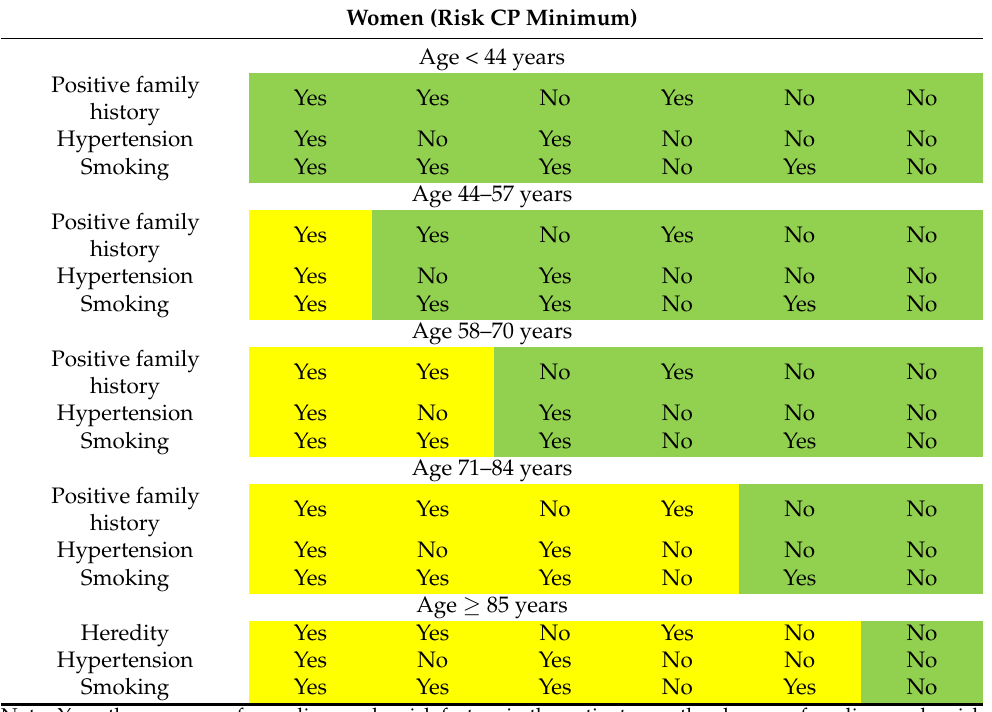
Table 11. Scale for assessing the risk of combined end point developing in women with defined and probable